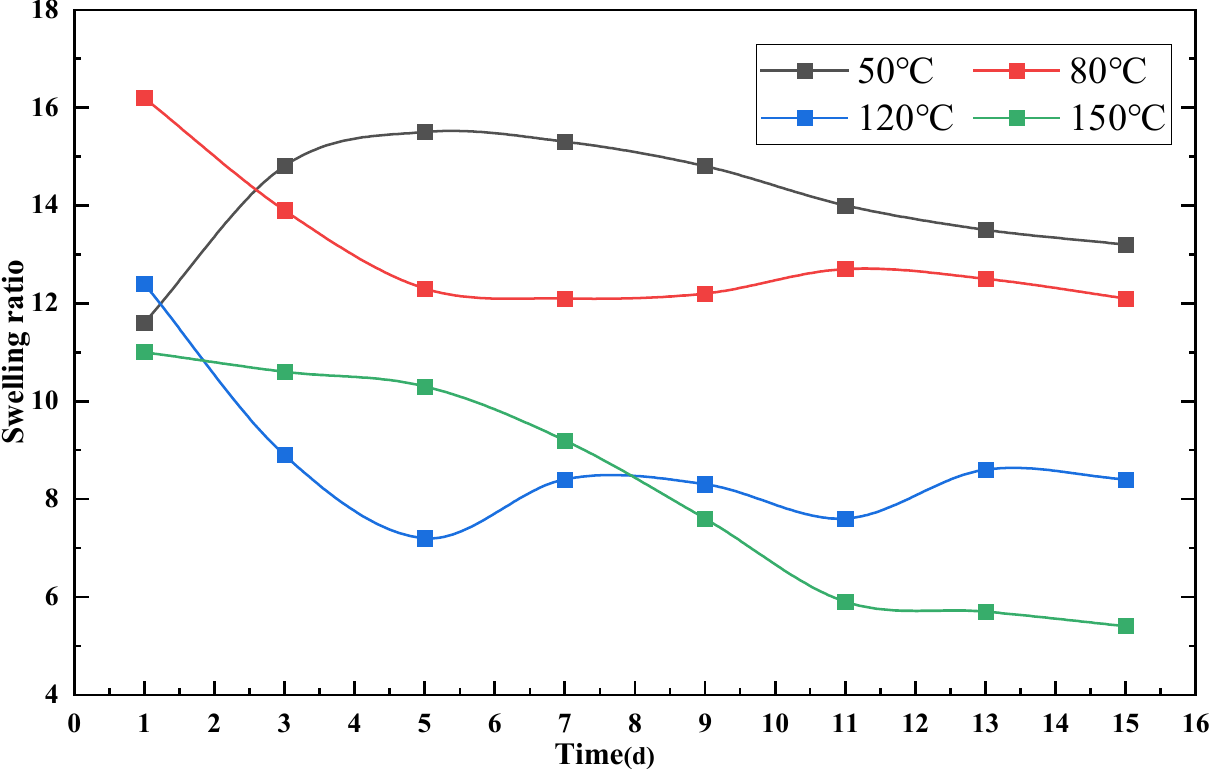
Figure 6. Influence of temperature on swelling property at 20 × 10 4 mg/L.